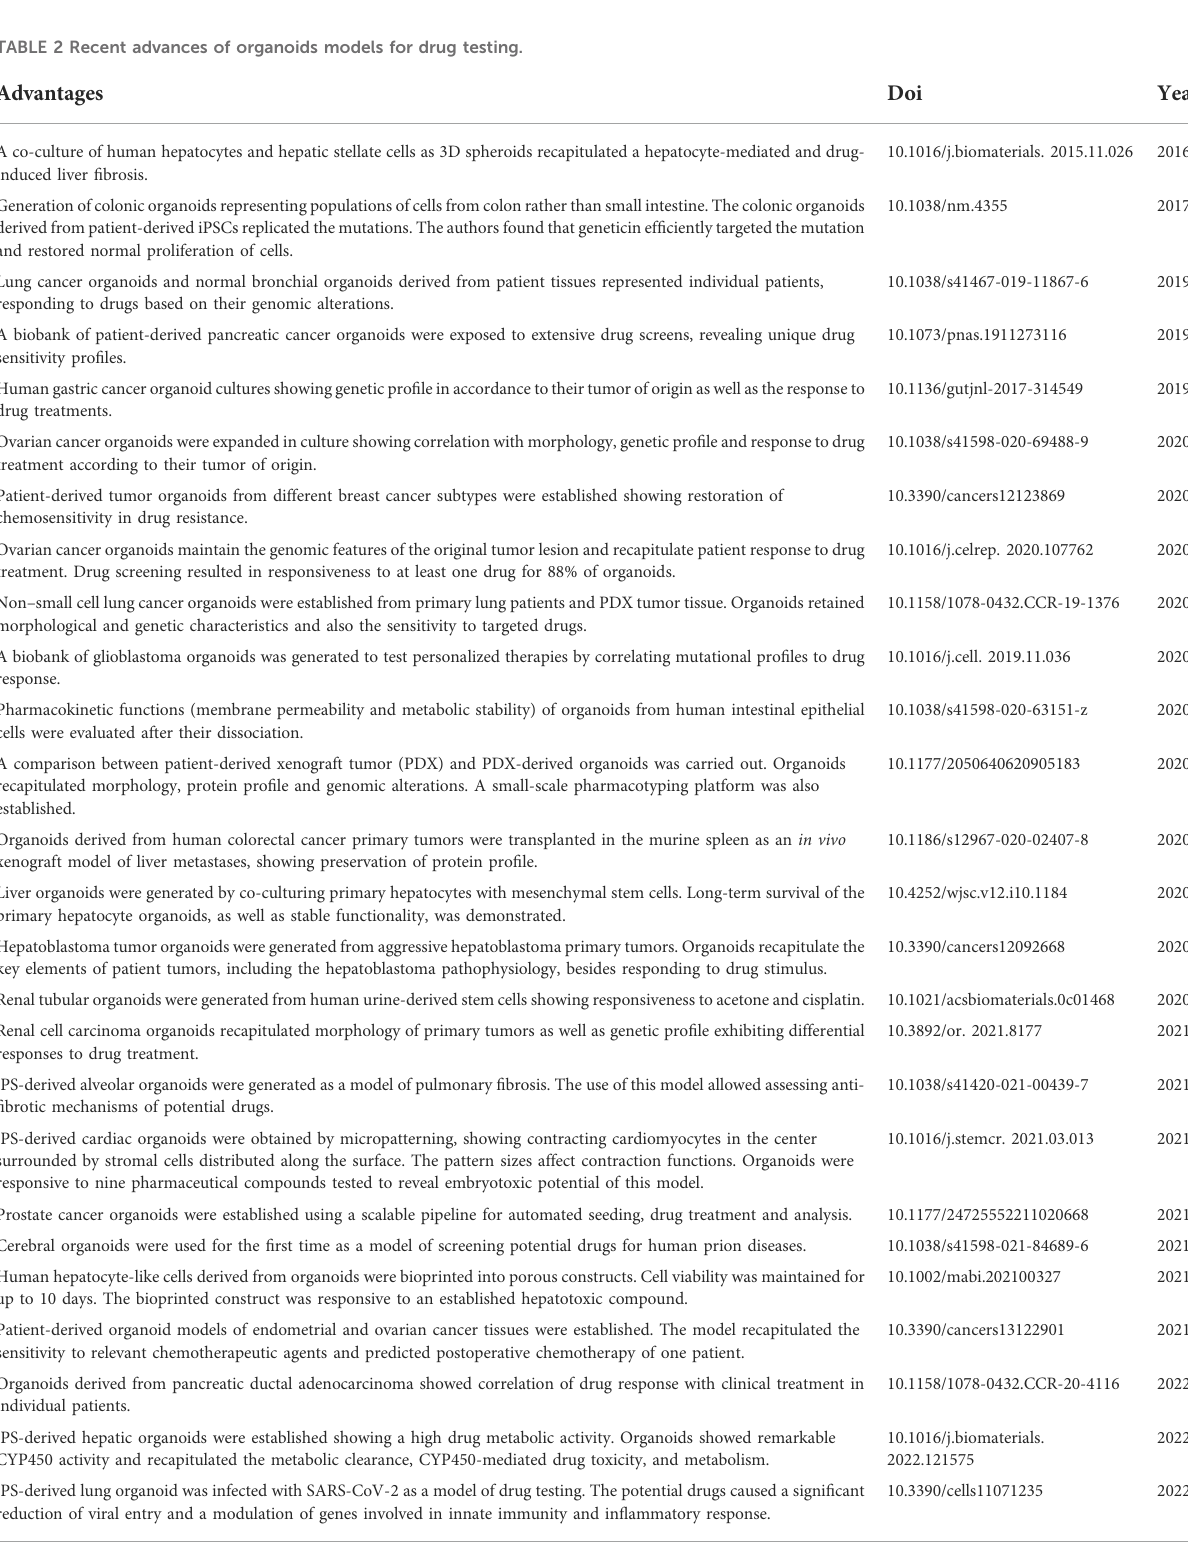
Tumor organoids or tumoroids have been extensively